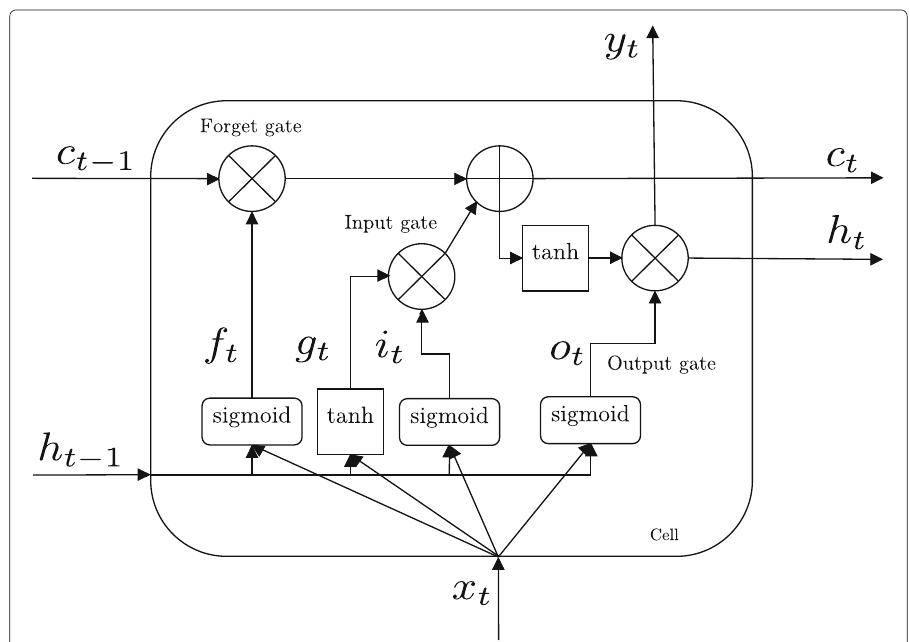
Fig. 8 LSTM cell. The cell can process data sequentially and keeps its hidden state h over the time